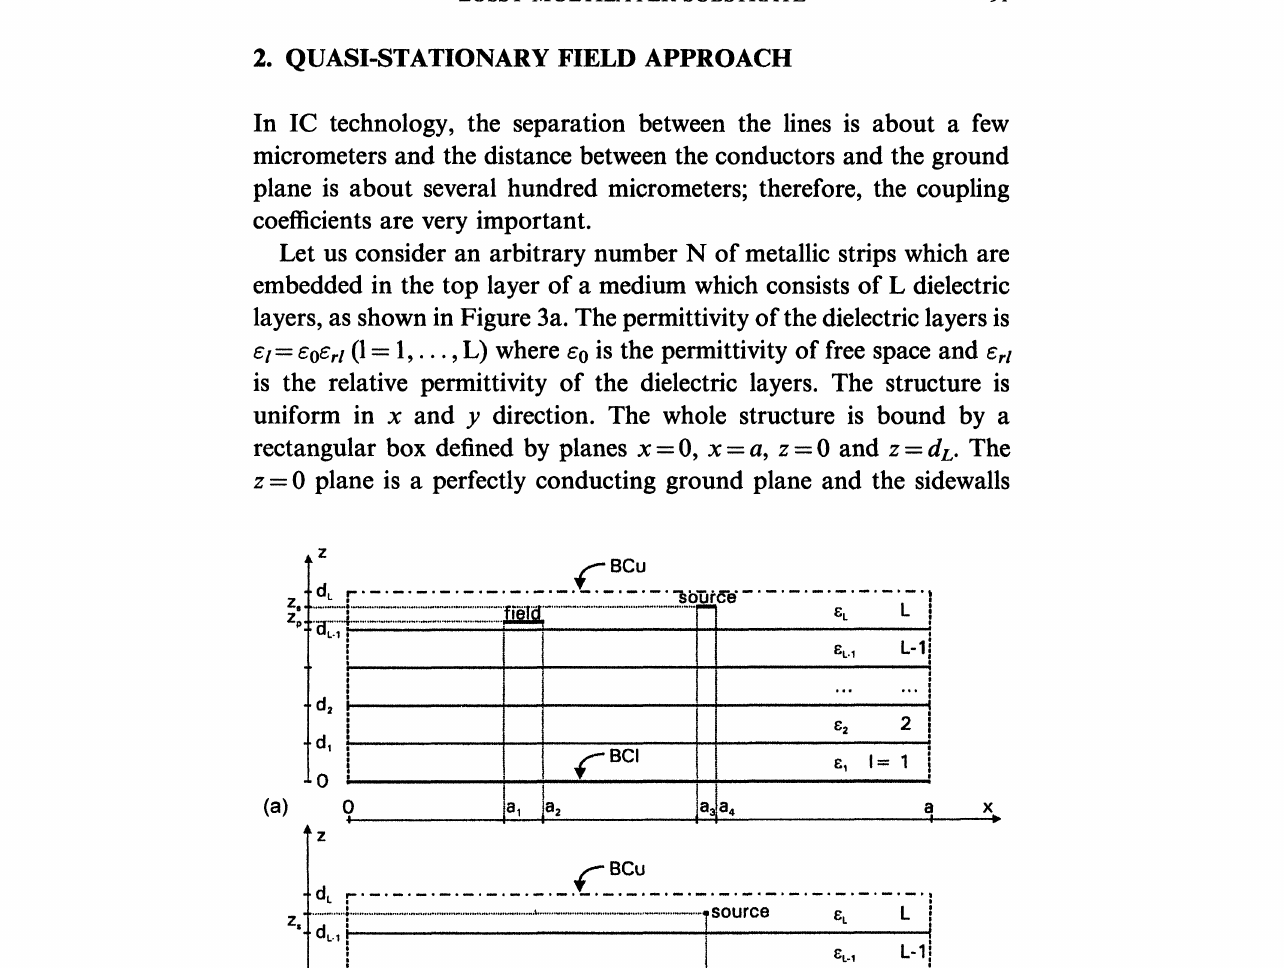
FIGURE 3 Geometry of a multilayer structure (a) with conductors in the top layer (b) for Green’s function